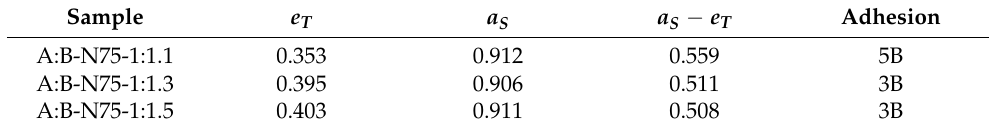
Table 2. Comparison of thermal emittance ( e T ), solar absorbance ( a S ) and adhesion to polymeric substrate of TISS coatings, prepared with the binder L200 and various concentrations of catalyst Desmodur N75.